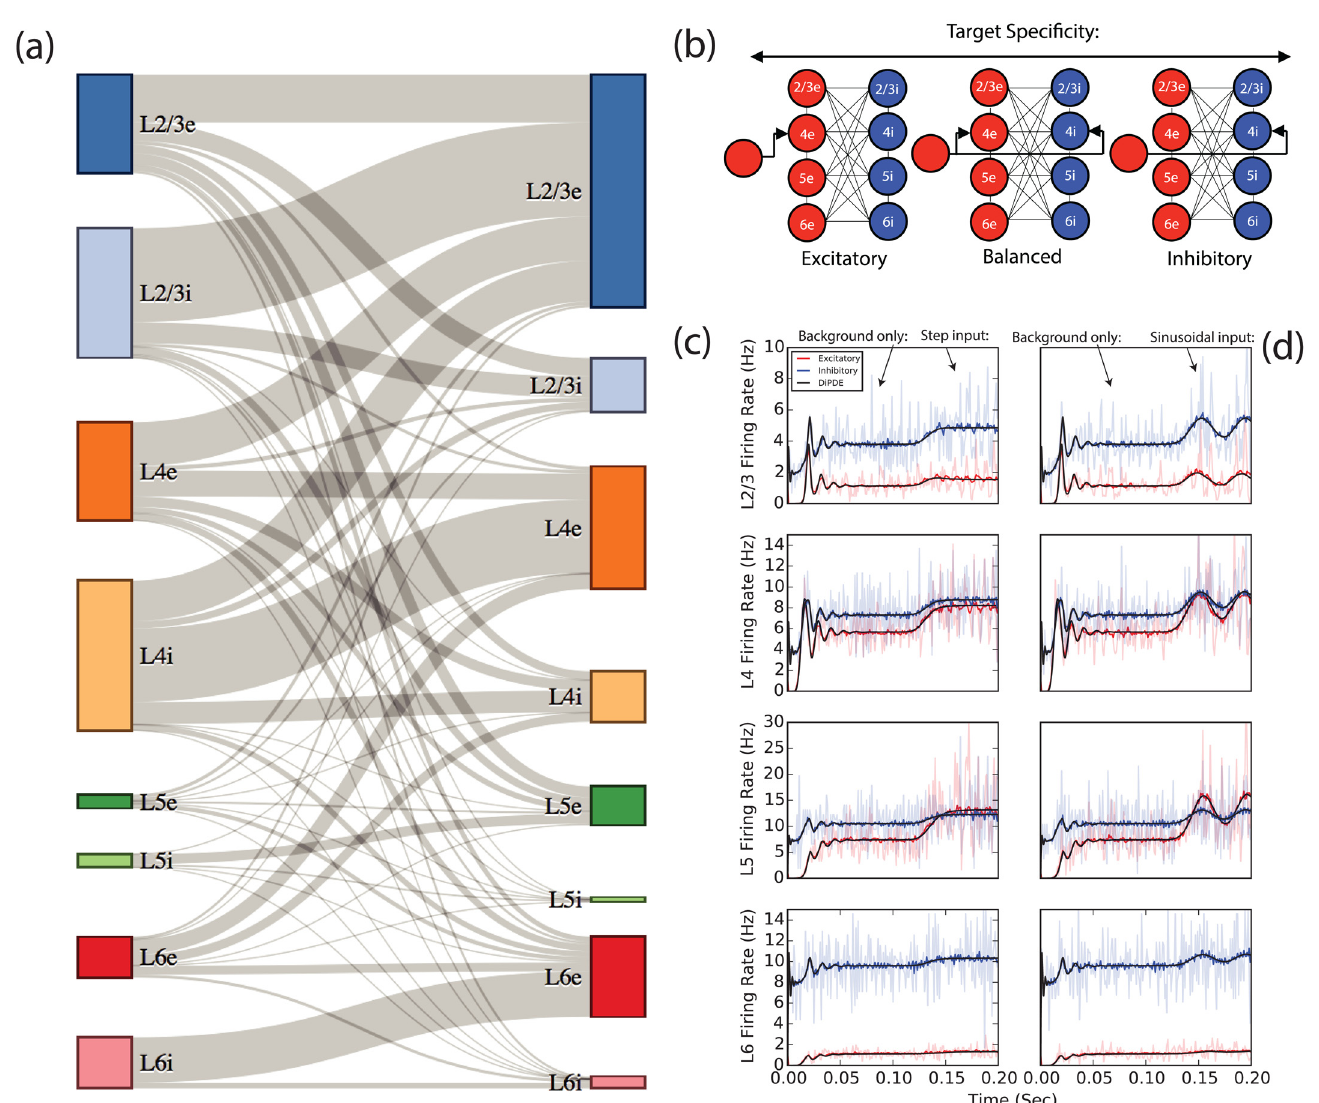
Fig 1. Model overview and comparison of population statistic model (DiPDE) with leaky integrate-and-fire (LIF) simulations. (a) Schematic overview of the connections between source (left) and target (right) populations. Line thickness corresponds to the number of projections between populations. The number of projections from inhibitory populations is scaled by 4 (the relative difference between inhibitory and excitatory synaptic strengths), so that excitatory and inhibitory projections can be visually compared. (b) The column model is perturbed in one of three ways: Excitatory, Balanced, or Inhibitory, illustrated here driving Layer 4. (c-d) Mean firing rate across all populations (1 ms bin width) of 100 averaged LIF simulations (solid fluctuating red trace for excitatory and blue for inhibitory subpopulation; a single example firing rate trace is rendered semi-transparent in the background) of the cortical column model. Black lines show prediction of DiPDE simulation across all layers under either (c) 20 Hz step or (d) sinusoidal with 20 Hz peak amplitude in firing rate, 24 Hz frequency inputs in excess of background excitation. At t = 100 ms, an additional input beyond the background excitation drives the excitatory population of layer 4 as illustrated in (b), “ Excitatory ” . Transient dynamics, steady-state firing rates, and responses to additional inputs are well approximated by DiPDE.